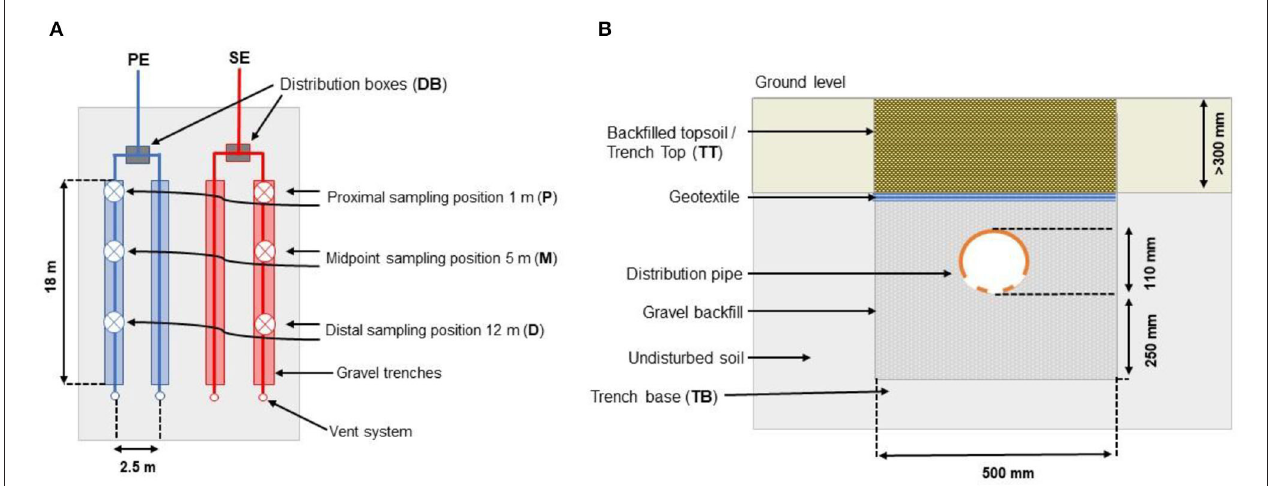
FIGURE 1 | (A) Horizontal and (B) vertical profile of the STU (Knappe et al., 2020).